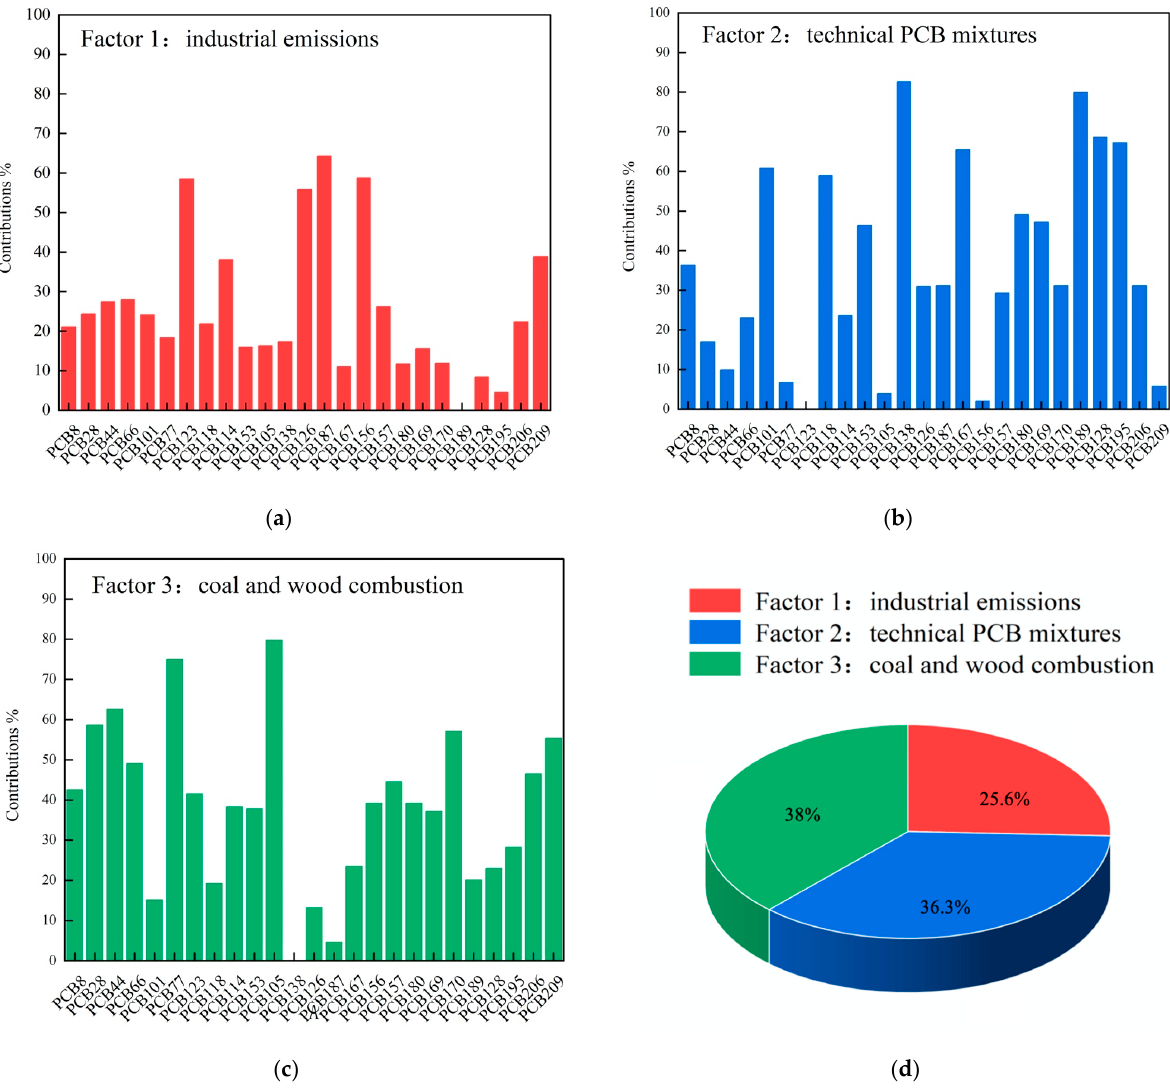
Figure 4. Positive matrix factorization source analysis of PCBs: ( a – c ) are the different factors, and the bars represent the contribution of each factor to the corresponding PCB. ( d ) The Pie chart showing the contribution of each factor to the total PCBs.